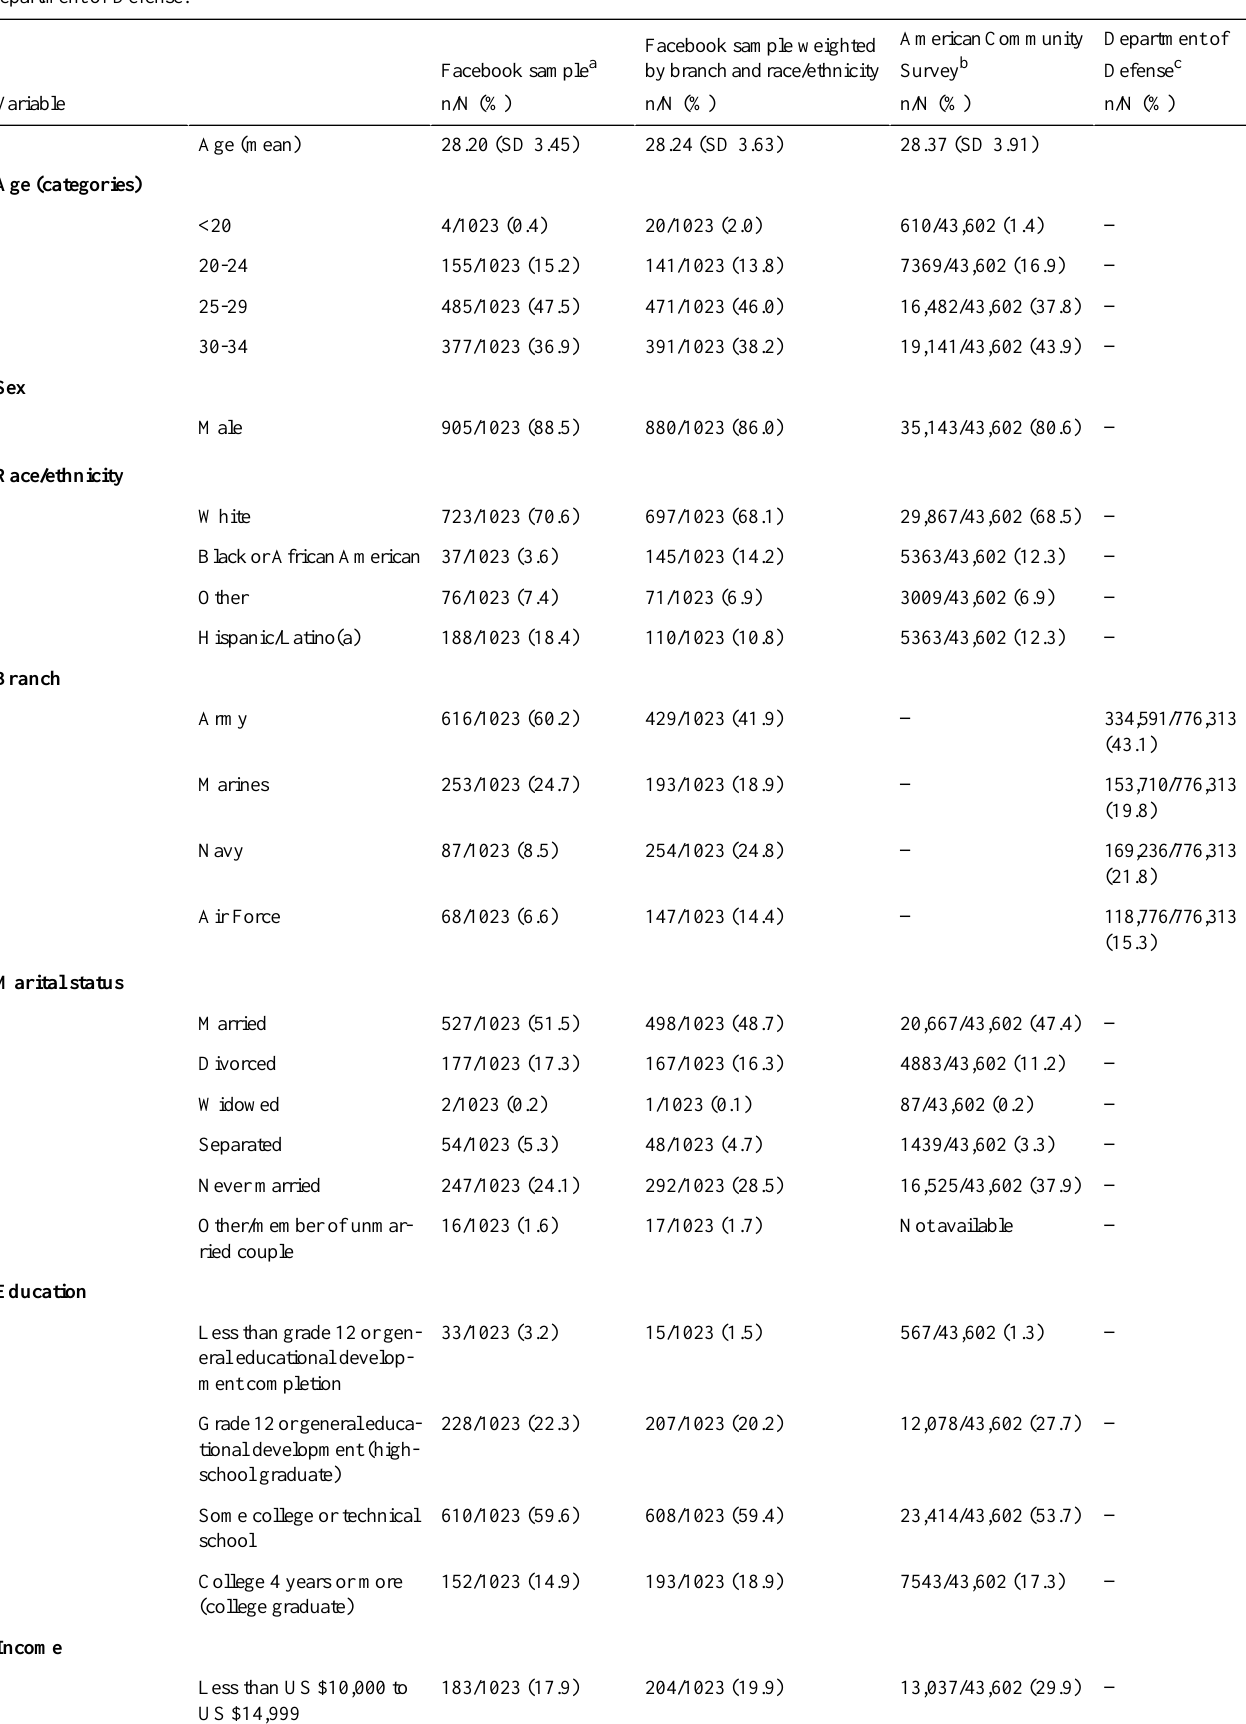
Table 1. Sample demographics of 1023 veteran participants with branch and ethnicity weights compared with American Community Survey and Department of